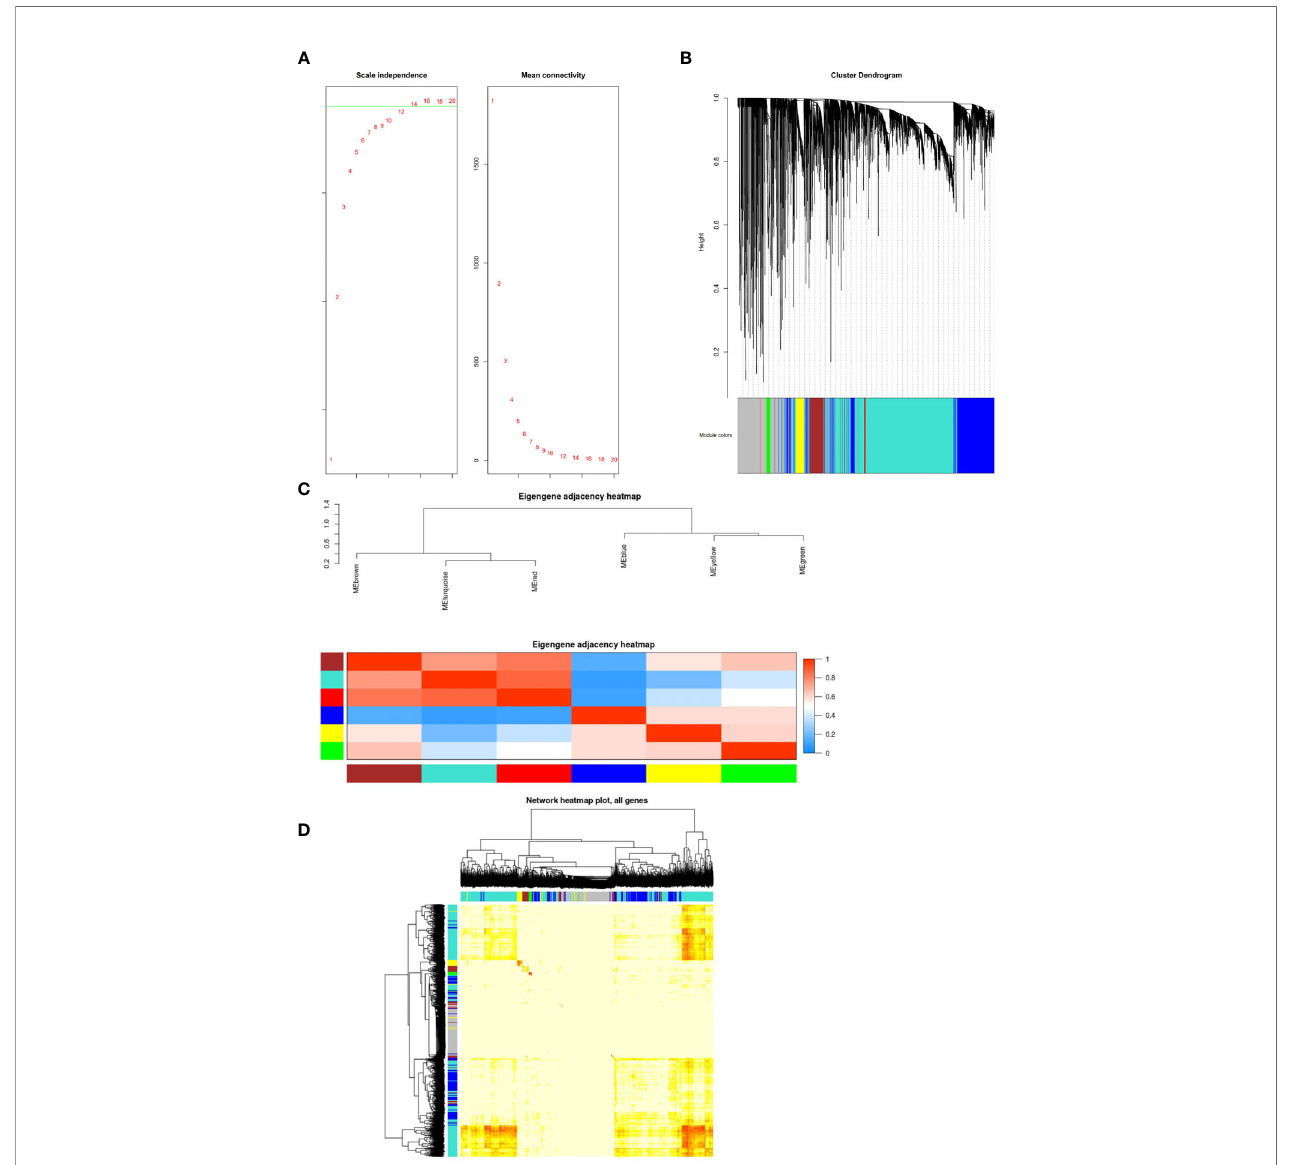
FIGURE 4 | (A) Construction of co-expression modules by the weighted gene co-expression network analysis (WGCNA) package in R. The default value of the parameter beta is 1 to 30. The horizontal axis of the graph above represents the weight parameter b , and the vertical axis of the left graph represents the square of the correlation coef fi cient between log (k) and log [p (k)] in the corresponding network. The higher the square of the correlation coef fi cient, the more the network approaches the distribution without network scale. The vertical axis of the right fi gure represents the mean of the adjacent function of all genes in the corresponding gene module. (B) The cluster dendrogram of genes in GSE54129. Each branch in the fi gure represents one gene, and every color below represents one co- expression module. (C) Clustering visualization of samples. Heatmap plot of the adjacencies in the hub gene network. Heatmap of the correlation between module eigengenes and the disease of gastric cancer. The red module was the most positively correlated with status, and the blue module was the most negatively correlated with status. (D) Interaction relationship analysis of co-expression genes. Different colors of horizontal axis and vertical axis represent different modules. The brightness of yellow in the middle represents the degree of connectivity of different modules. There was no signi fi cant difference in interactions among different modules, indicating a high-scale independence degree among these